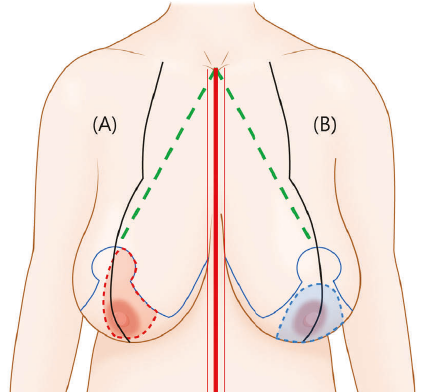
Figure 4: Preoperative design and pedicle selection in reduction mammoplasty using the inverted T technique. (a) The super- omedial pedicle design is typically used in patients with an intact blood supply on the nipple-areolar complex. (b) In patients with breast cancer adjacent to the superomedial pedicle, the inferior pedicle design is used. The distance between the sternal notch and the upper margin of the neo-nipple-areolar complex is 18–21cm (green dotted line). The thick red line represents the midline, and the thin red lines represent skin tissue